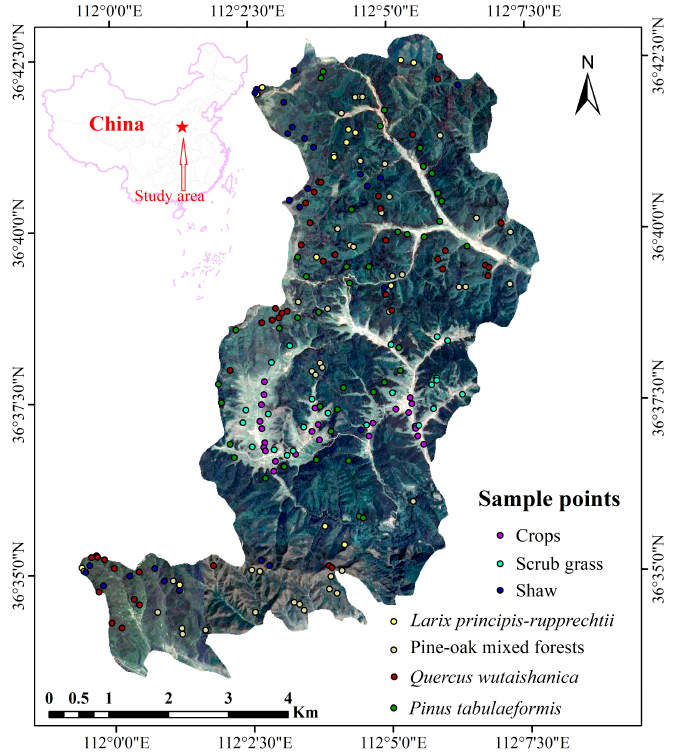
Figure 1. Location of the study area.